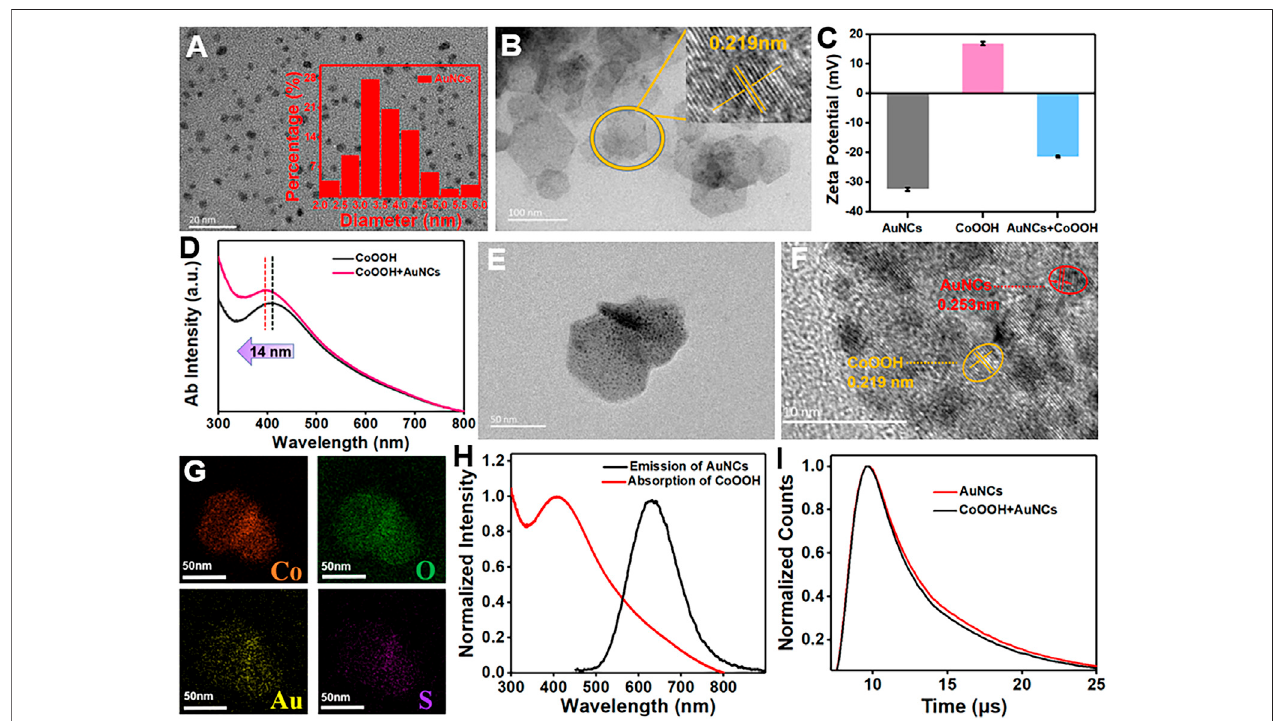
FIGURE 1| (A) TEM image of AuNCs. (B) TEM image ofCoOOHNFs. (C) Zeta potential of CoOOH NFs, AuNCs, and the mixture of CoOOH NFs/AuNCs. (D) The UV – vis absorption spectrum of CoOOH NFs and CoOOH NFs + AuNCs. (E) TEM image ofCoOOH-AuNCs. (F) HRTEM imageof CoOOH-AuNCs. (G) EDS mapping of CoOOH-AuNCs. (H) AuNC fl uorescencespectrum(blackline)andtheCoOOHNFsUV – visabsorptionspectrum(redline). (I) FluorescencelifetimeofAuNCsandAuNCs + CoOOH